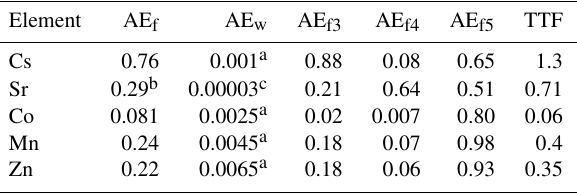
agreement with Kasamatsu and Ishikawa (1997), where